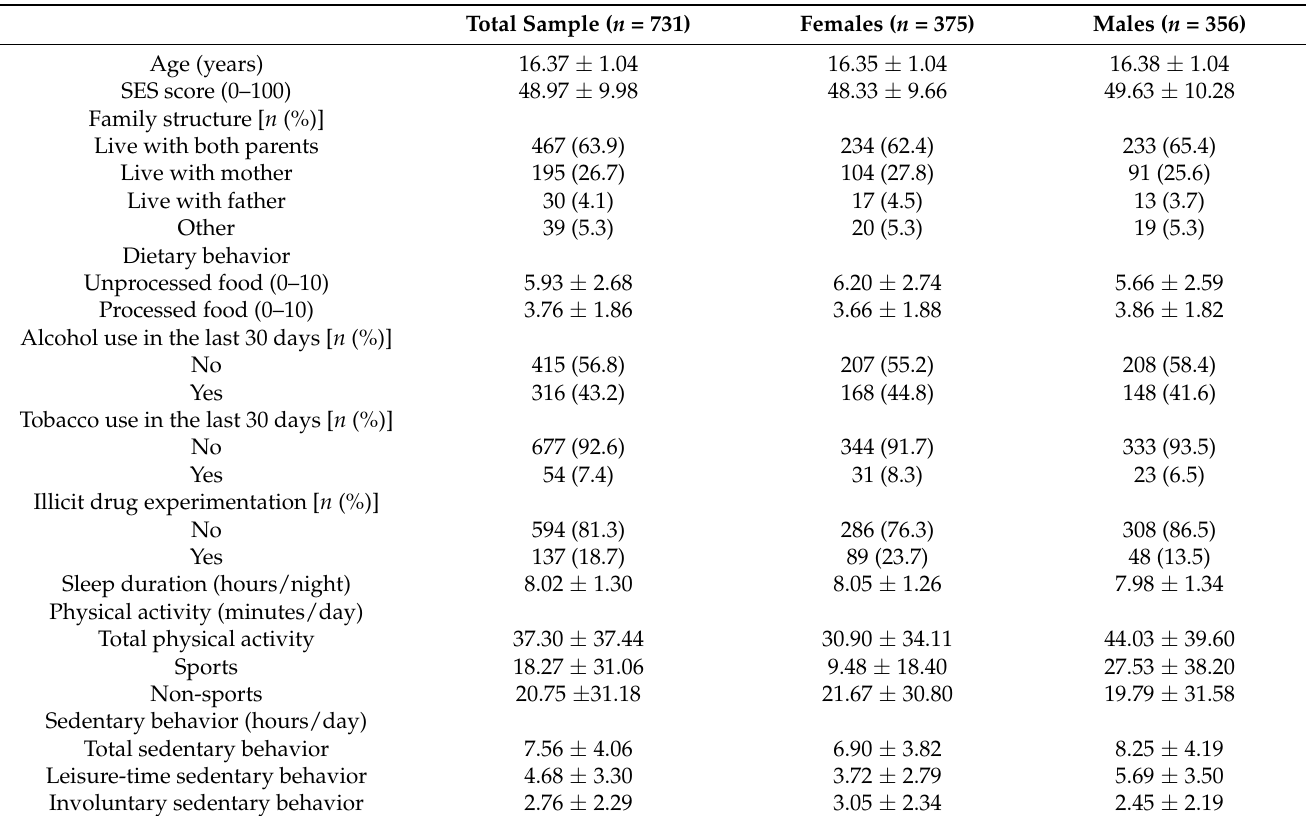
Table 1. Characteristics of the sample (mean ± SD or n